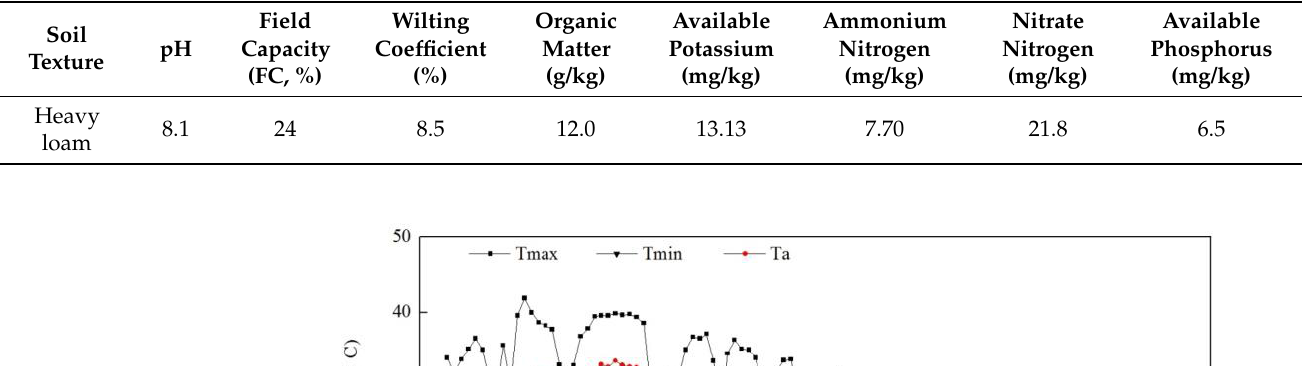
Table 1. Physical and chemical properties of the experimental soil.